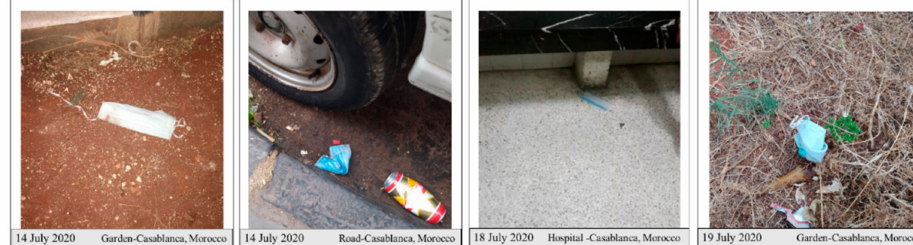
Figure 1. Pictures of discarded facemasks in roads and gardens, Casablanca,